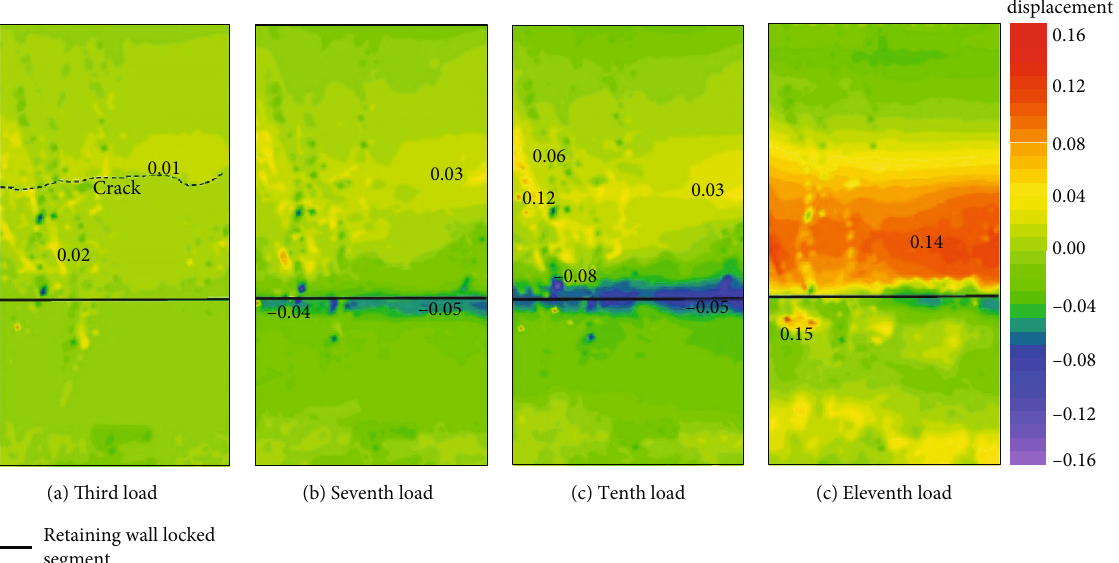
Figure 10: Cloud maps of the cumulative vertical displacement of the landslide with retaining wall locked